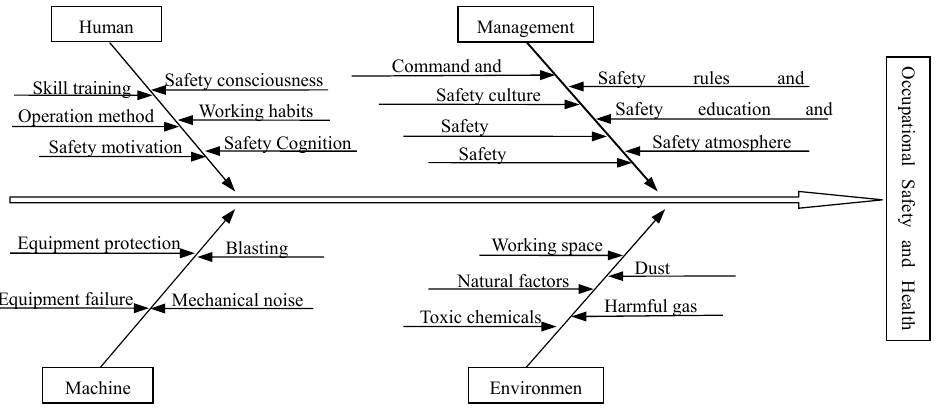
Figure 1. Fishbone diagram of occupational safety and health (OSH) influencing factors.